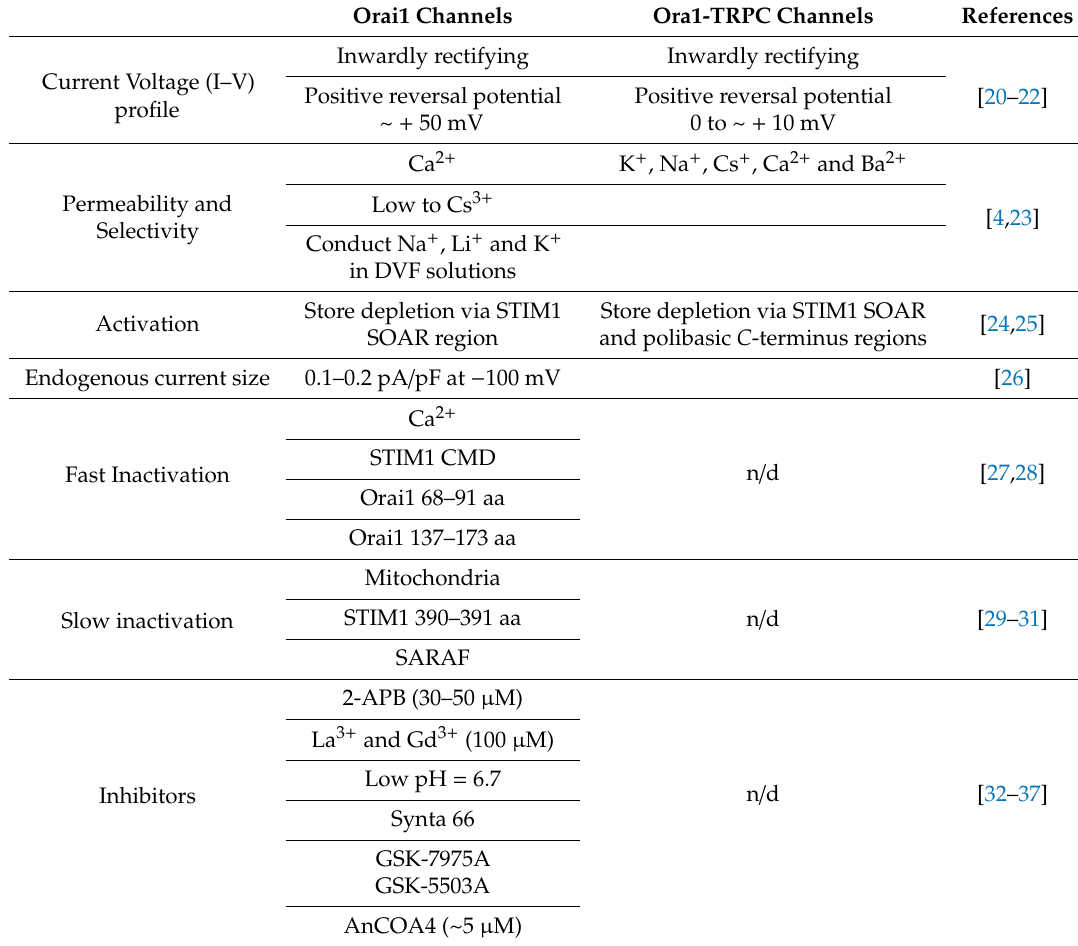
Table 1. Biophysical features of store-operated Ca 2 + channels. Notes: STIM1 CMD: